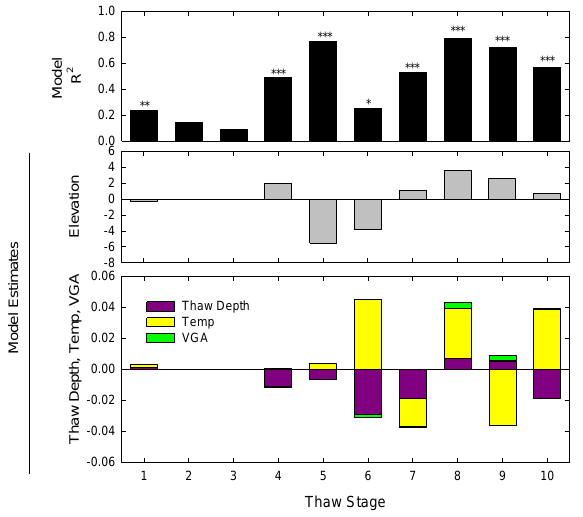
Figure 6. Multiple regression of CH 4 fluxes with elevation, thaw depth, soil temperature (temp) and vascular green area (VGA) for each thaw stage (thaw stage 1 = intact permafrost, 10 = completely thawed). Model fit R 2 values are reported along with model esti- mates (stacked bars). Significance of the R 2 is denoted by asterisk ( ∗ for p < 0.05, ∗∗ for p < 0.01, and ∗∗∗ for p < 0.001). Soil tem- perature was not a statistically significant estimate for any of the thaw stages. Elevation was significant for thaw stages 1, 4, 8 and 9; thaw depth for 1, 4, 5, 7, 8 and 10; and VGA for 8 and 9.